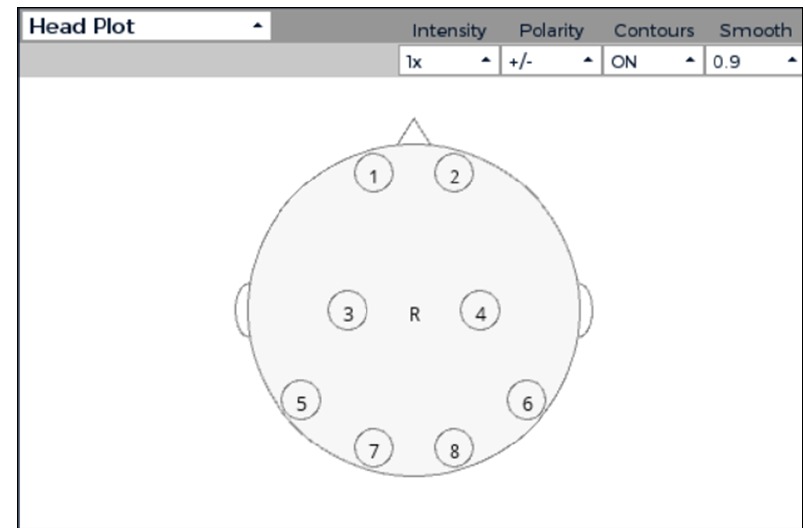
Fig. 1. 10-20 system of electrodes placement.